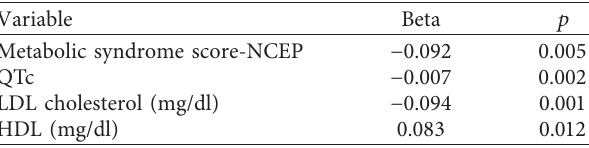
Table 5: Multivariate analysis. Multiple linear regression model (stepwise procedure) with 25(OH)D as the dependent variable and body mass index (BMI), metabolic syndrome score of the National Cholesterol Education Program (NCEP), metabolic syndrome score of the International Diabetes Federation (IDF), systolic blood pressure, LDL cholesterol, non-HDL cholesterol, glycemia, CRP, C3, and QTc.